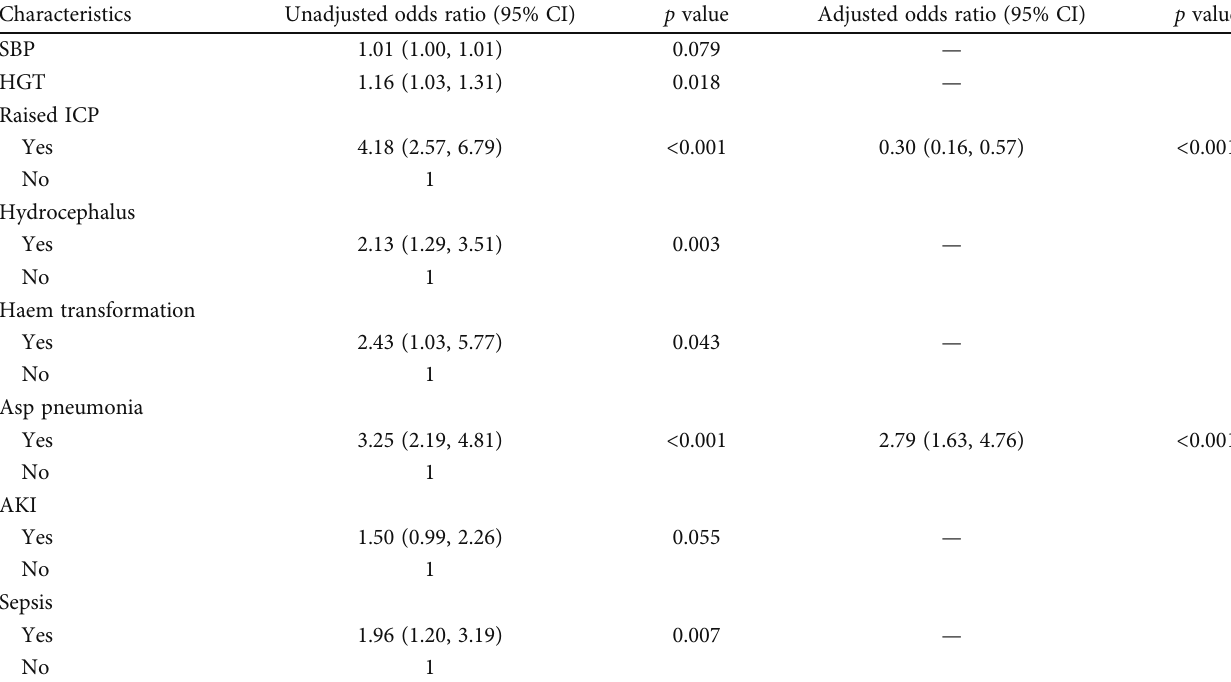
Table 3: Univariate and multivariate analyses of the in-hospital